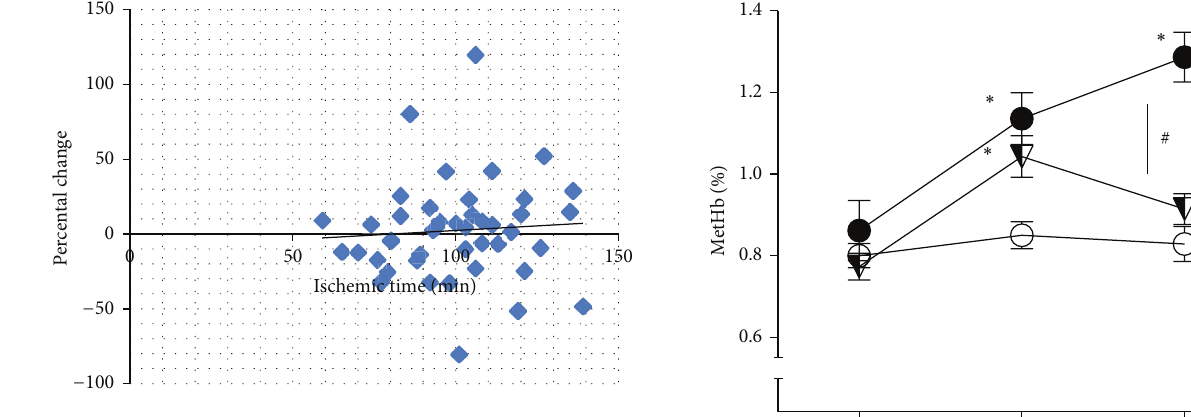
Figure 3: Correlation between percental change (blood sample at time points one and two) and ischemic time, exemplified by soluble P-selectin (all three groups). 𝑅 2 = 0.0048 , ns.